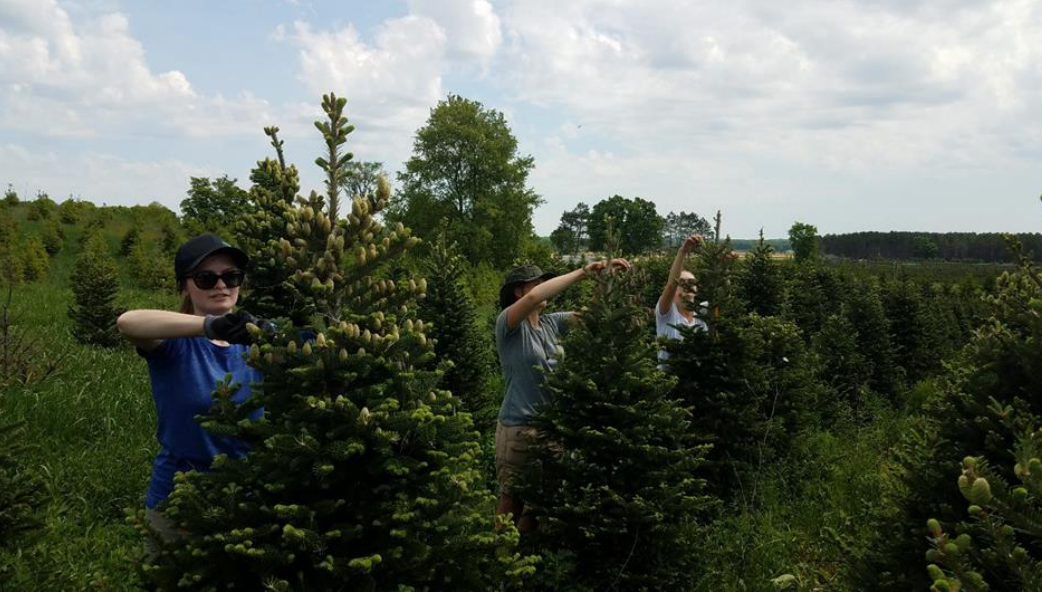
Figure 3. Research assistants assess coning on Fraser fir Christmas trees.